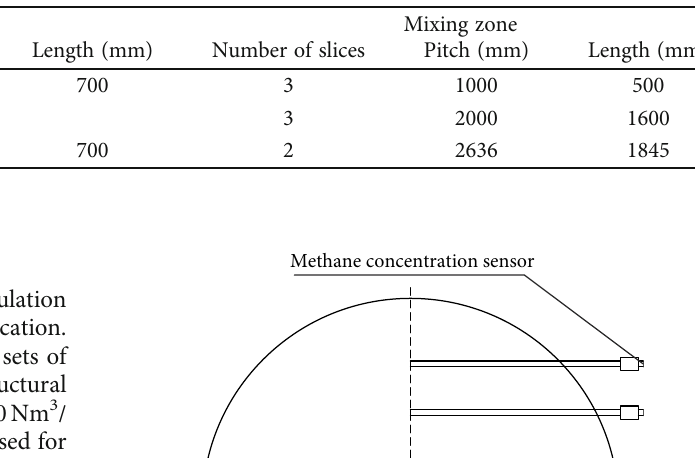
Table 1: Structural parameters of gas mixing unit during processing.